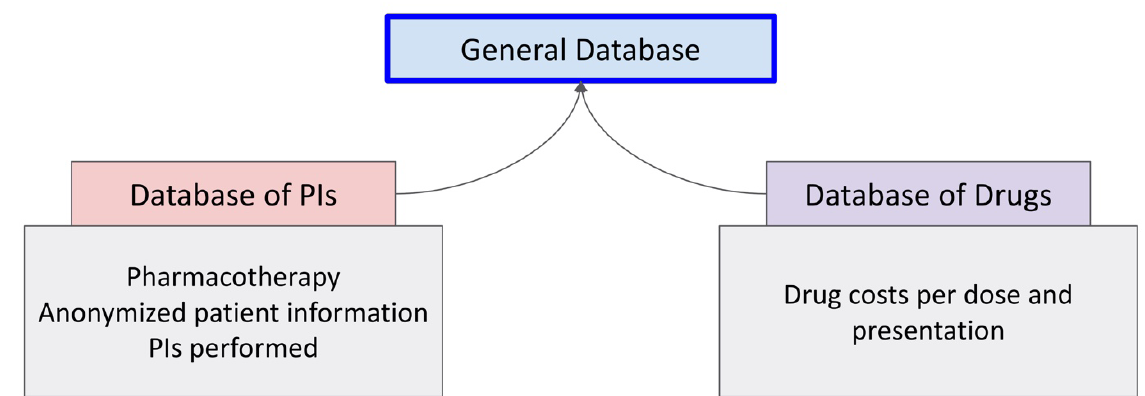
FIGURE 1 - Flowchart for data analysis. The arrows indicate that both PIs and Drugs Databases are compiled into the General